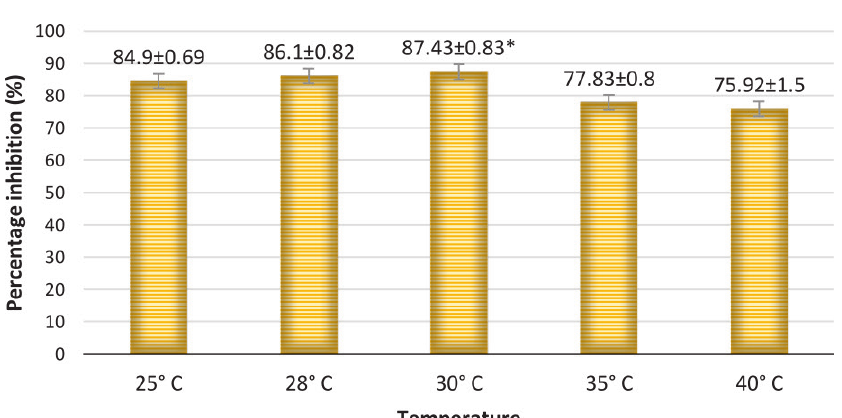
Fig. 10. Percentage inhibition of A. flavus at different temperatures where maximum inhibition was observed at a temperature of 30°C. Inhibition percentage = (Radius of Control- Radius of Test/ Radius of Control) x100. Values are represented as Mean ± SD (n=3). *Value is statistically significant at P ≤ 0.05 in t- test